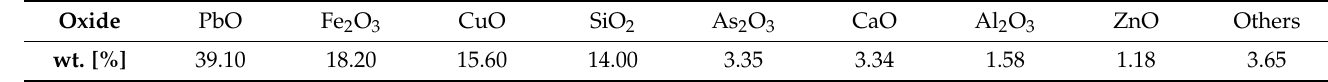
Table 3. Chemical composition of test slag